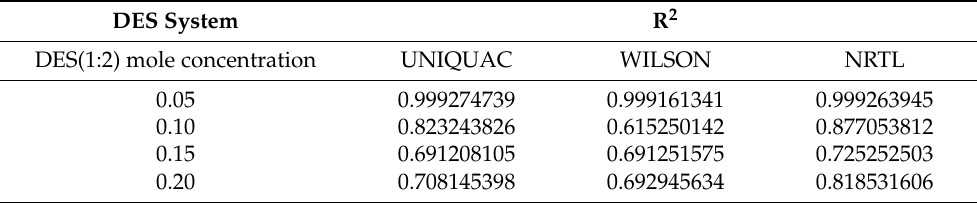
Table 10. Coefficient of determination (R 2 ) of the pseudo-ternary systems fitting using the three thermodynamic